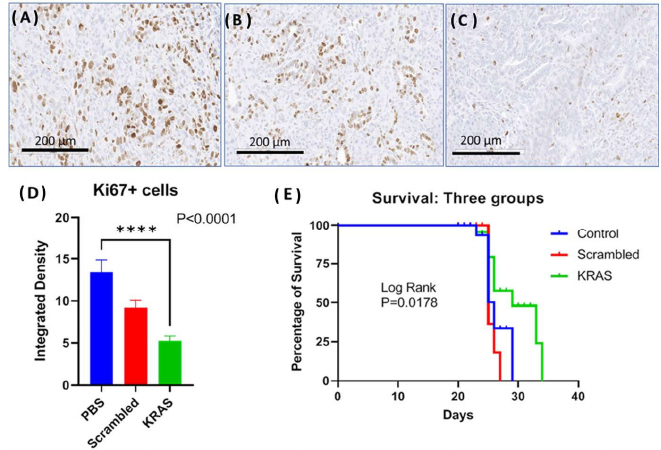
Figure 6. Effects of targeted NP loaded with muKras and WT-Kras siRNA on growth and survival of mice bearing mT3 syngeneic orthotopic pancreatic tumors. ( A ) Ki67 immunohistochemistry staining of a representative control tumor shows abundant proliferating cells. ( B ) Representative image from a tumor of a scrambled-siRNA NP treated mouse, Ki67 immunohistochemistry staining. ( C ) Representative image from an mT3 tumor of a mouse treated with the NP loaded with siRNA for muKras and WT-Kras shows fewer Ki67 immunoreactive cells . (D ) Quantitative analysis of all the tumors reacted with the Ki67 antibody shows fewer immunoreactive cells in the mice treated with the muKras and WT-Kras siRNA compared to controls ( p < 0.0001). ( E ) Kaplan Meier survival curves shows a significant survival benefit in mice treated with the NP loaded with Kras siRNA compared to controls and those treated with the scrambled siRNA ( p = 0.0178). **** p < 0.0001.